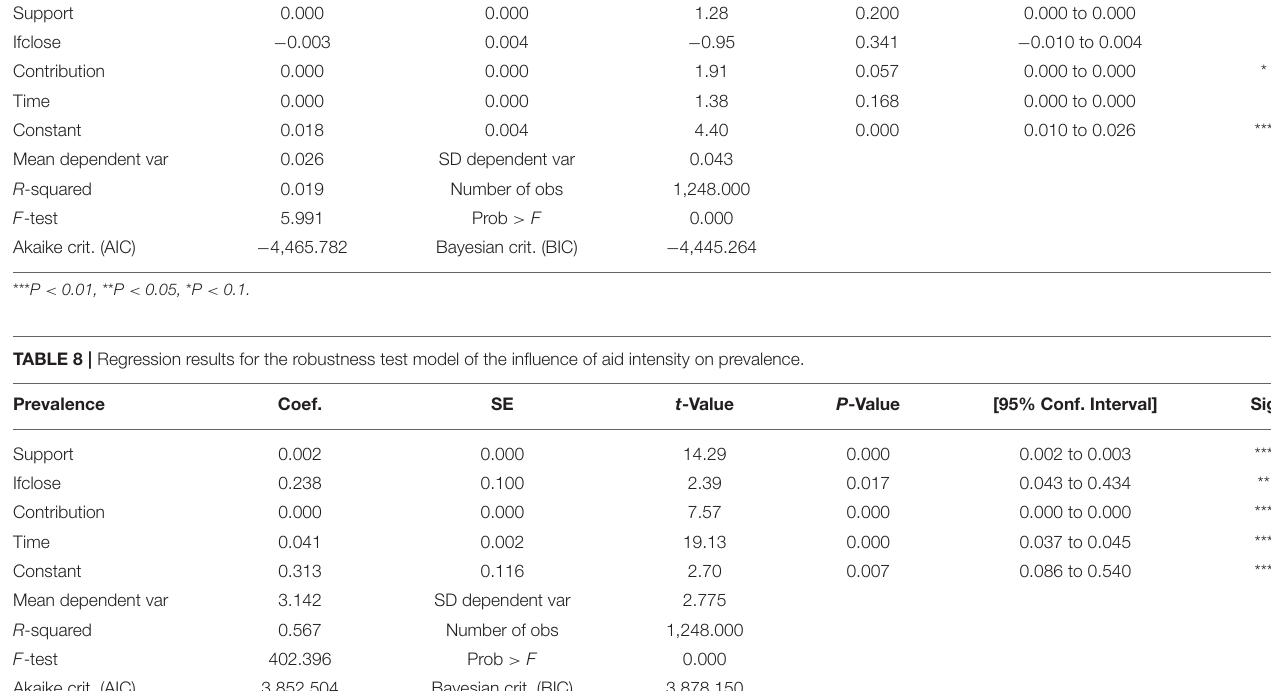
TABLE 7 | The regression results for the two-way fixed effects model of the influence of aid intensity on the fatality rate. Frate Coef. SE t -Value P -Value [95% Conf. Interval] Support 0.000